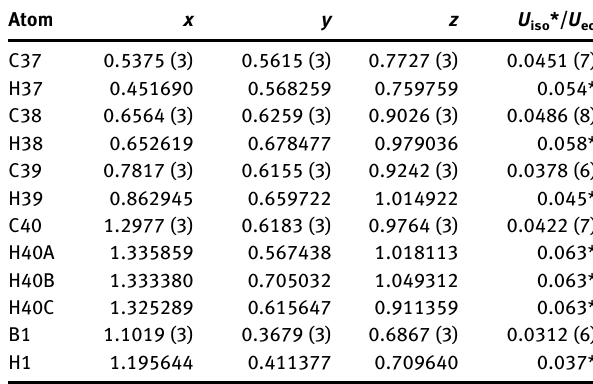
Table  : Fractional atomic coordinates and isotropic or equivalent isotropic displacement parameters (Å 